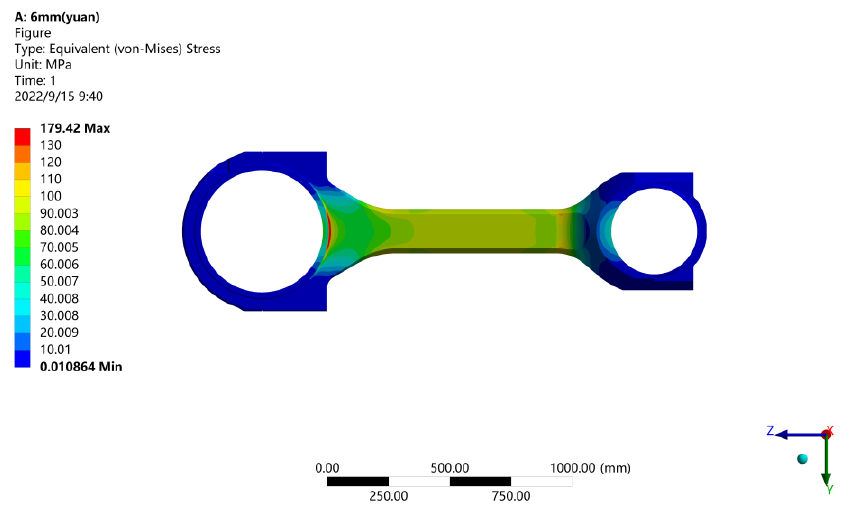
Figure 9. Stress diagram of the connecting rod assembly.